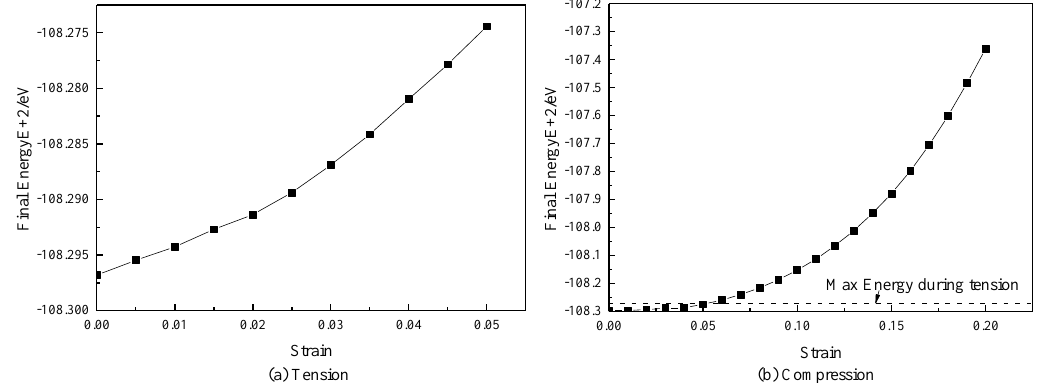
Figure 6. The change in energy in the process of tension and compression. ( a ) tension, and ( b ) compression.